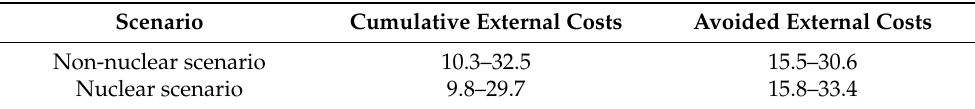
Figure 5. The range of avoided external costs associated with the power sector in Poland from 2018 to 2050 according to ( a ) the non-nuclear scenario, and ( b ) the nuclear scenario (million EUR 2018). Table 10. Cumulative and avoided external costs associated with the Polish power sector in 2018–2050 (billion EUR